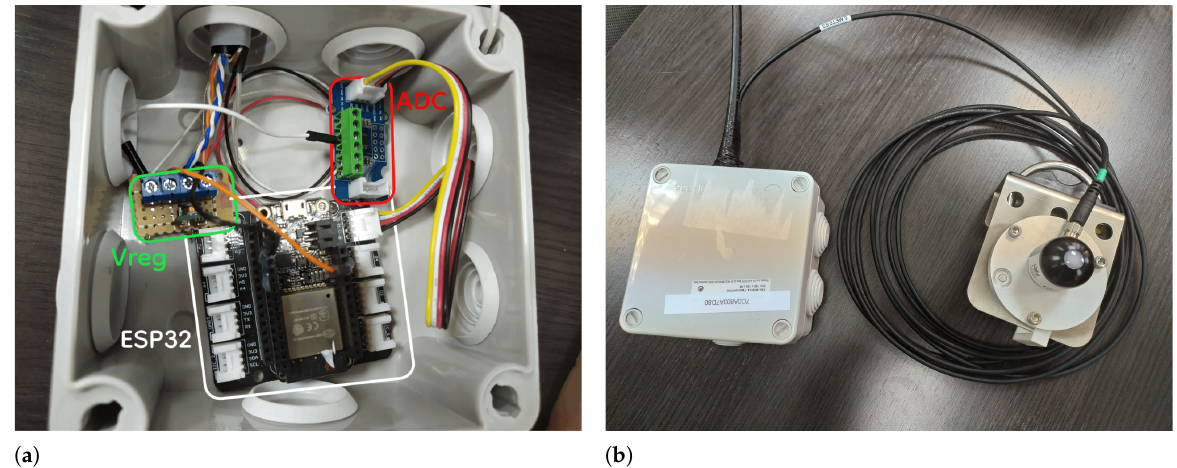
Figure 3. Inside and outside looking of the mote prototype. ( a ) Elements inside the box with Voltage Regulator (marked as Vreg); ( b ) box and